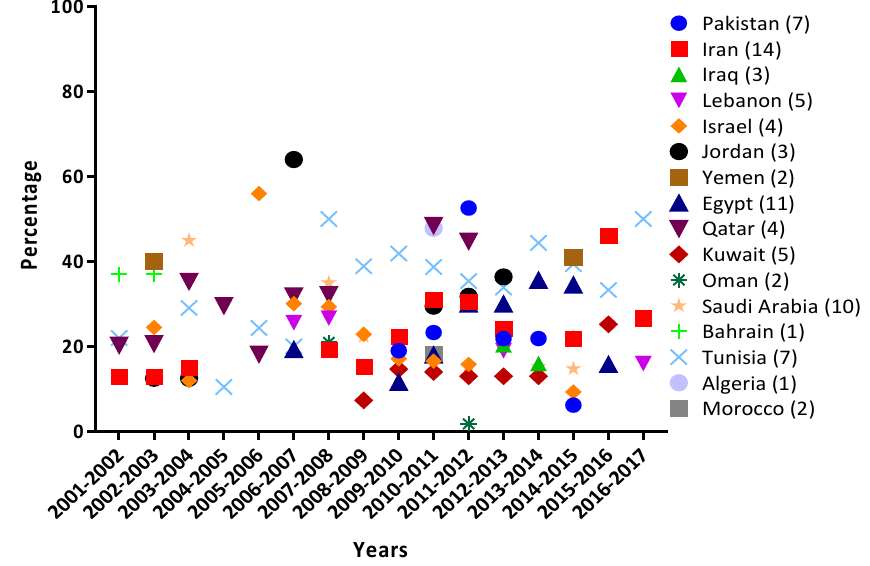
Figure 2. Annual rate of prevalence of Respiratory Syncytial Virus infection in the MENA region detected from